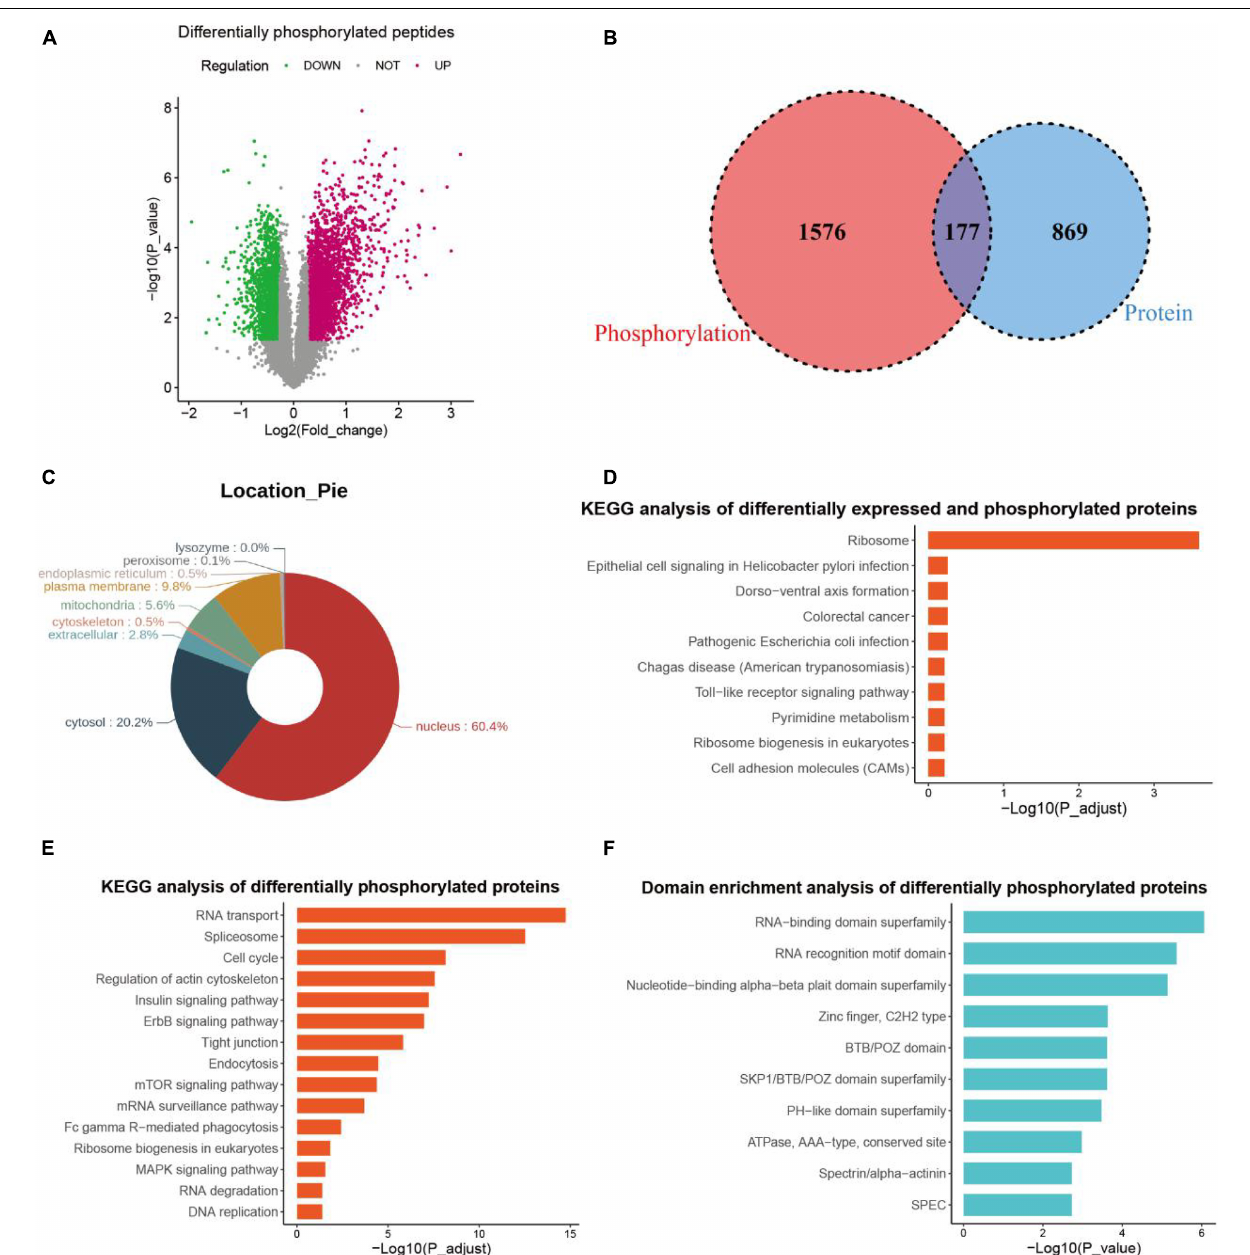
FIGURE 4 | Phosphoproteomics profiling. (A) The volcano plot of differentially phosphorylated peptides of PANC-1 cells treated with anlotinib. (B) The venn plot of differentially expressed proteins and differentially phosphorylated proteins of PANC-1 cells treated with anlotinib. (C) Cellular location analysis of differentially phosphorylated proteins of PANC-1 cells treated with anlotinib. (D) KEGG analysis of differentially expressed and phosphorylated proteins of PANC-1 cells treated with anlotinib. (E) KEGG analysis of all differentially phosphorylated proteins of PANC-1 cells treated with anlotinib. (F) Domain enrichment analysis of all differentially phosphorylated proteins of PANC-1 cells treated with